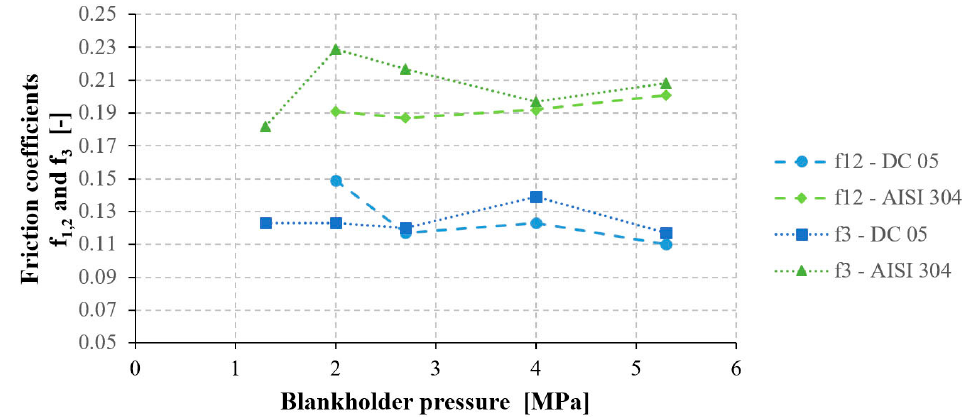
Figure 7. Dependence of friction coefficient f 1,2 on the blankholder pressure.